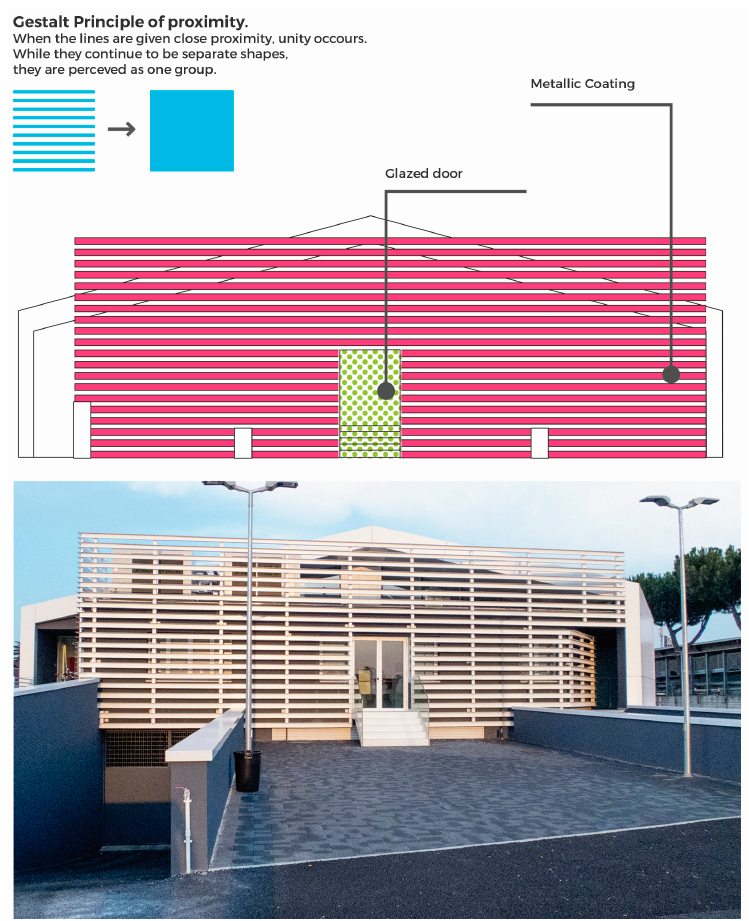
Figure 7. Back façade on GRA inner carriageway (image by Rosario Di